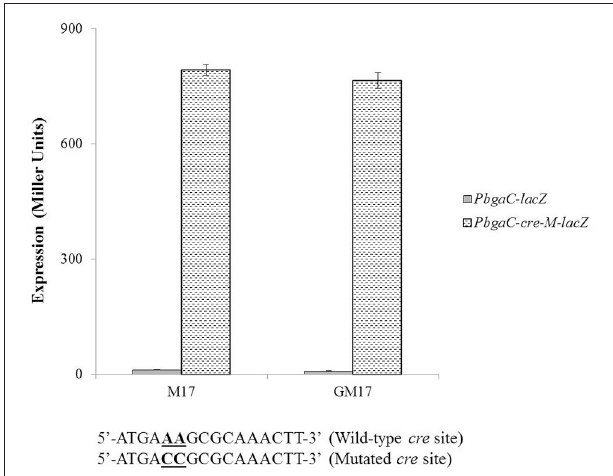
FIGURE 5 | Expression levels (in Miller units) of P bgaC-lacZ and P bgaC-cre-M-lacZ in D39 wild-type grown in M17 (with no added sugar) and GM17 (0.5% Glucose + M17). Standard deviations of three independent experiments are indicated in bars. Wild-type and mutated cre sites in P bgaC are given